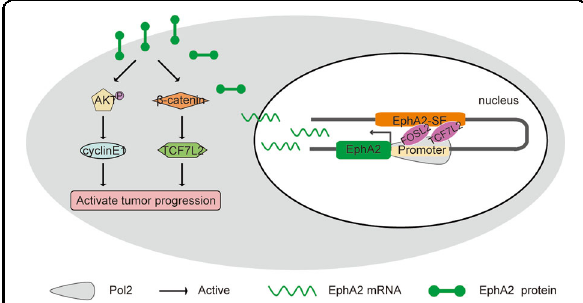
Fig. 6 Proposed model of transcriptional regulation of EphA2-SE in HeLa, HCT-116 and MCF-7 cells. EphA2-SE interacts with the EphA2 gene promoter and promotes transcription by recruiting FOSL2 and TCF7L2, resulting in abnormally high expressionof EphA2, which activates signal pathways to promote tumor